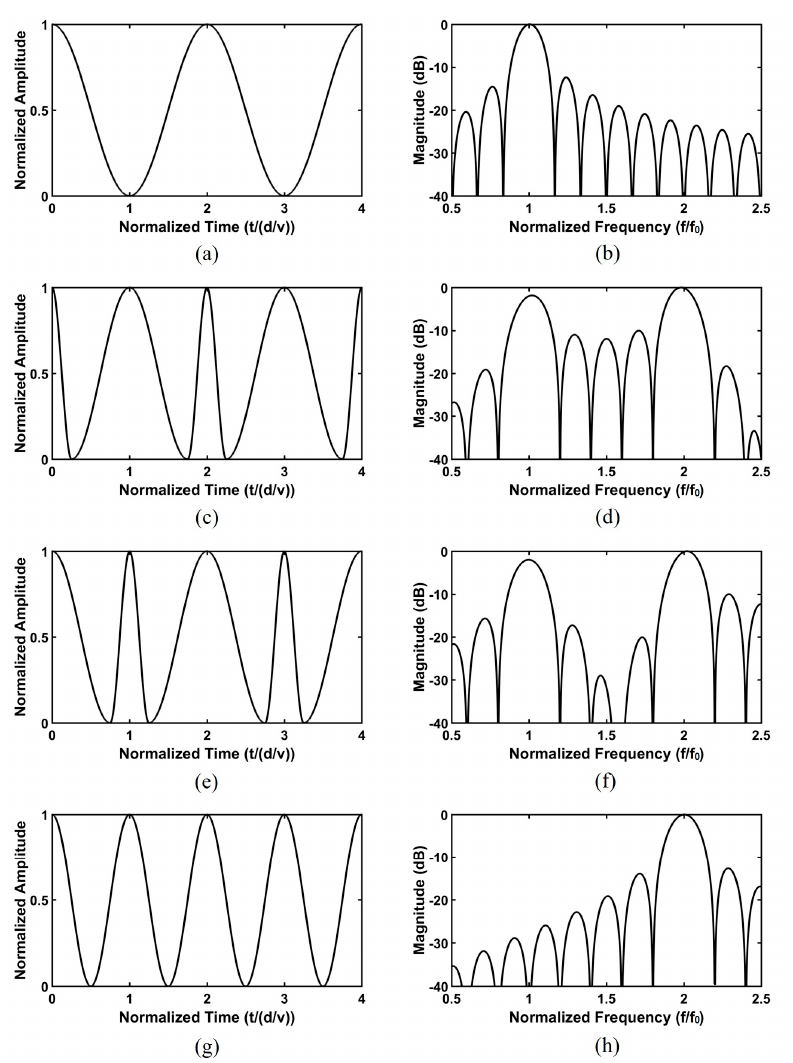
Figure 2. Time and frequency responses of the radiated ultrasound waves at interface A for each case in Figure 1 based on MATLAB simulations: ( a ) Time and ( b ) frequency domain responses of the conventional model, ( c ) time and ( d ) frequency domain responses of the PIT with a 0.25 inversion ratio (front-side inversion model), ( e ) time and ( f ) frequency domain responses of the PIT with a 0.25 inversion ratio (back-side inversion model), and ( g ) time domain and ( h ) frequency domain responses of the PIT with a 0.5 inversion ratio (half inversion model).